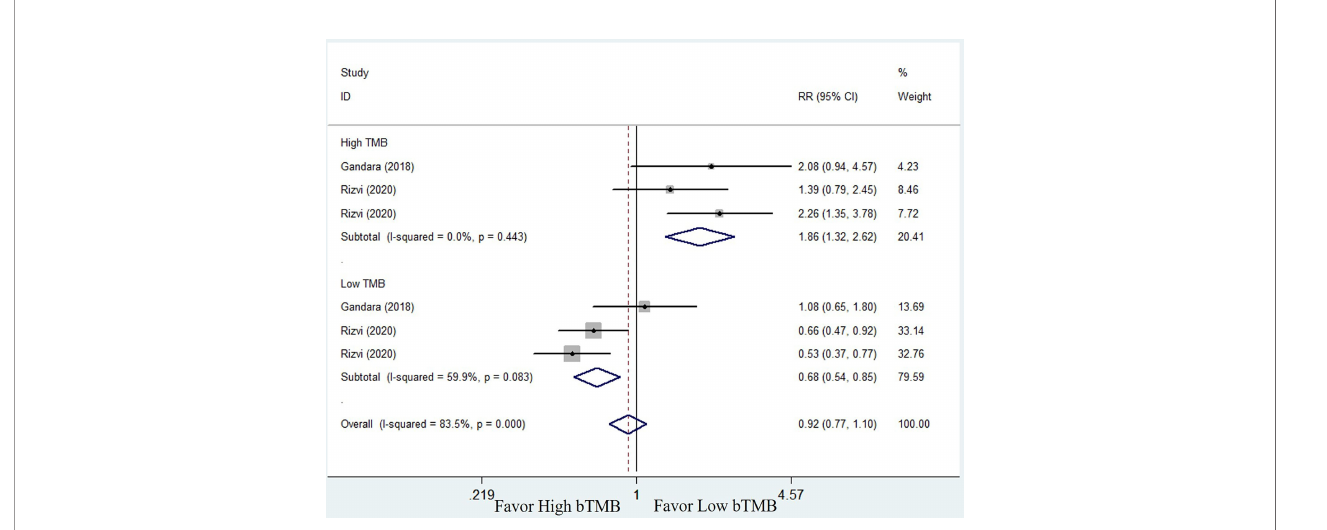
FIGURE 6 | Forest plot of ef fi cacy comparison of ICIs to chemotherapy for objective response rate (ORR) and subgroup